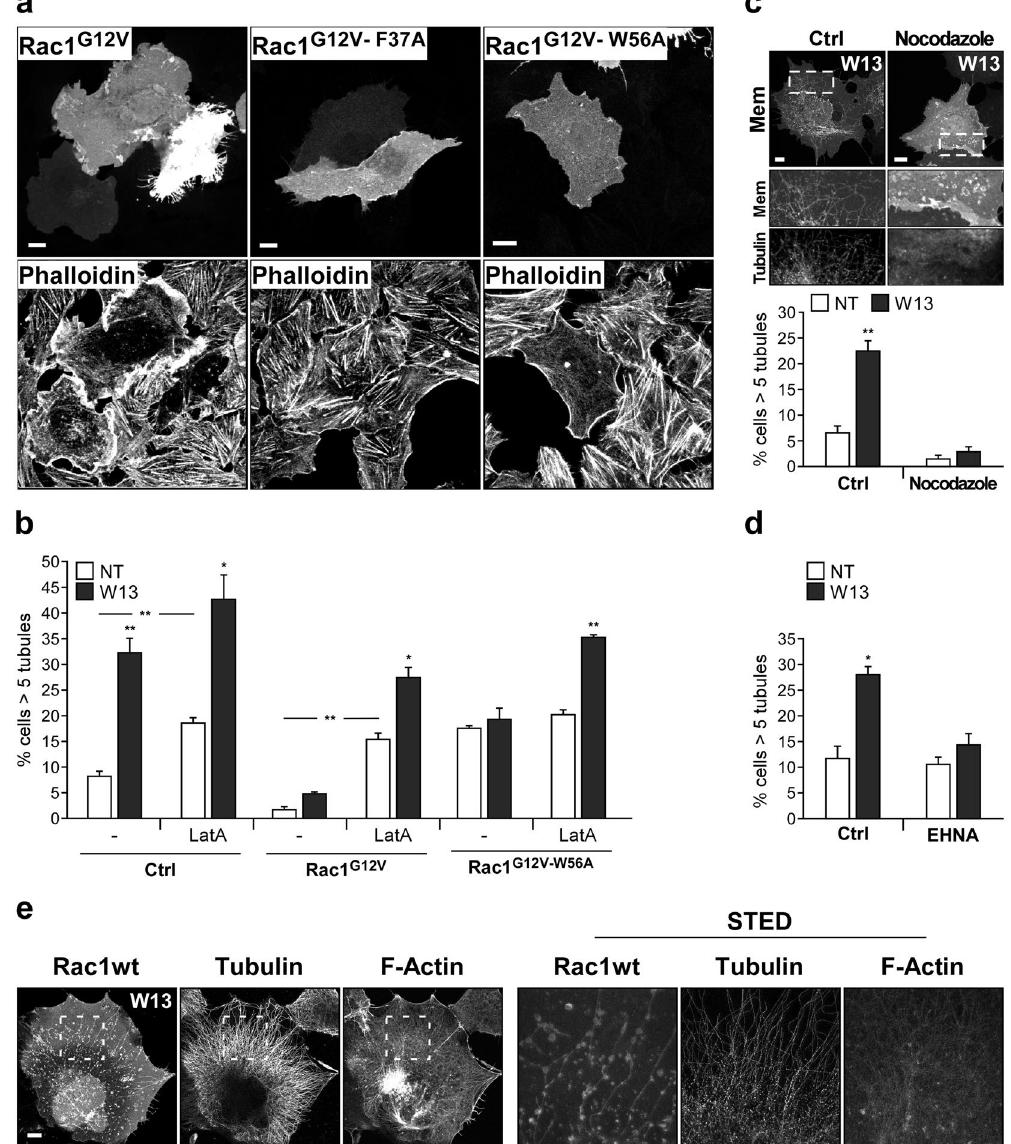
Figure 4. Actin cytoskeleton is involved in Rac1-dependent tubule inhibition. ( a ) Vero cells expressing GFP- Rac1 G12V , GFP-Rac1 G12V-F37A , or GFP-Rac1 G12V-W56A were grown on coverslips, and F-actin was visualized by confocal microscopy using phalloidin-TRITC (15 min, 0.04 U/ml) (bars, 10 µ m). ( b ) The percentage of COS1 cells presenting tubules was determined in starved cells expressing GFP-Rac1 G12V or GFP-Rac1 G12V-W56A and treated with the F-actin depolymerizing agent latrunculin A (LatA; 20 min, 200 nM) in the presence or absence of W13. ( c , d ) Percentage of cells with tubules expressing GFP-mem after pre-incubation with nocodazole (10 min, 30 µ M) ( c ) or the dynein inhibitor EHNA (6 hours, 1 mM) ( d ) and incubation with W13 for 20 min. Mean values ± standard error of the mean (SEM) from three independent experiments are shown in all cases. Statistical significance between W13-treatment and the corresponding control were determined by Student’s t -test, * p < 0.05, ** p < 0.01. ( e ) In cells expressing Venus-Rac1wt and treated with W13, tubulin was detected by immunofluorescence using a mouse anti- β -tubulin antibody and a secondary anti-mouse-Alexa594, and F-actin was detected using SiR actin (SC006). Representative confocal images and STED images from the selected areas are shown (bars, 10 µ